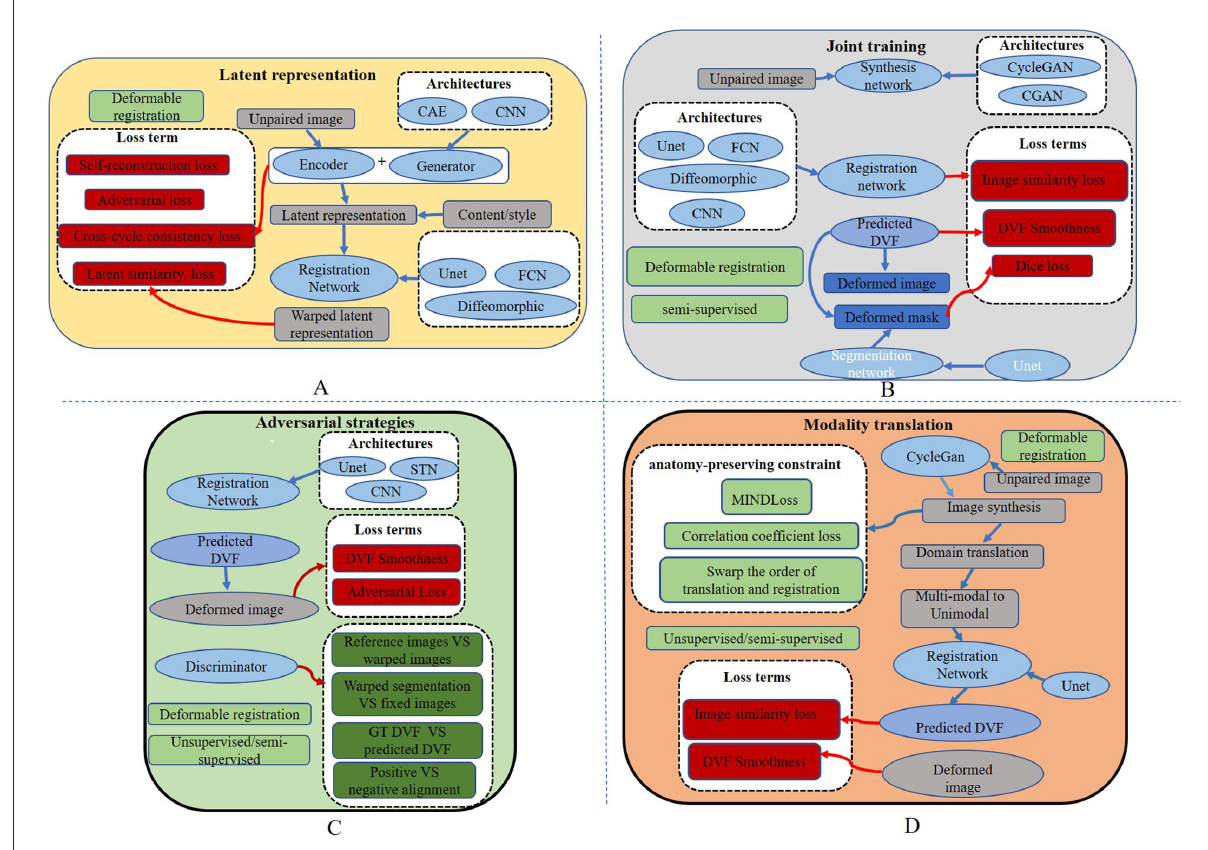
FIGURE3 Overall structures of existing cross-modal image registration methods. (A) The overall structure of the latent representation method. (B) The overall structure of joint learning-based strategy. (C) The overall structure of adversarial learning-based strategy. (D) The basic structures of modality translation.